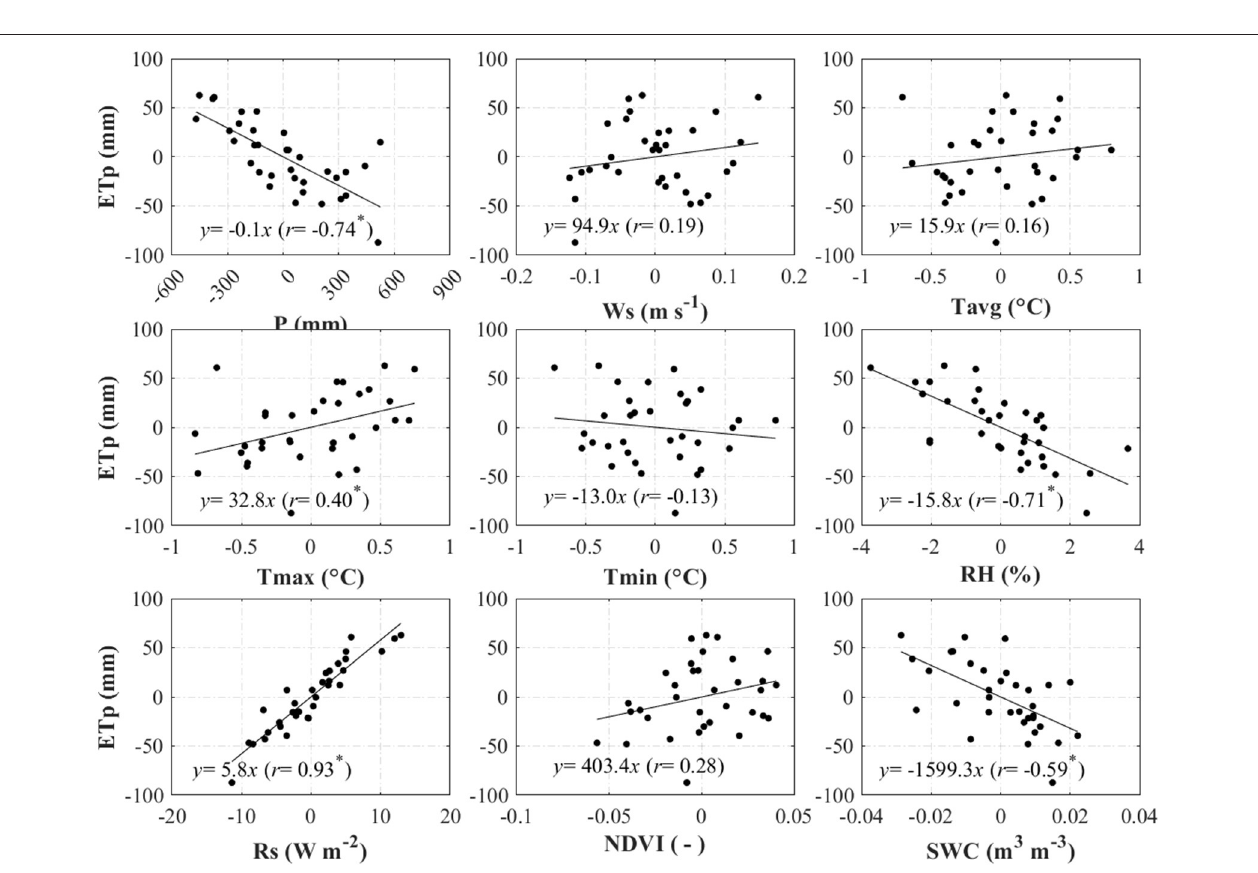
FIGURE 5 | Scatterplots of annual ET p against different variables over the entire province. Data were detrended (for monthly, seasonal and annual data) and deseasonalized (for monthly data) before the partial correlation analysis. Asterisk infers a statistically significant linear relationship.